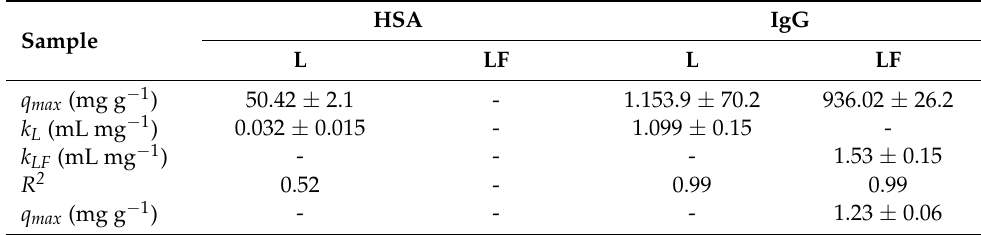
Table 4. Adjusted parameters by Langmuir and Langmuir–Freundlich (LF) for protein adsorption (HSA and IgG diluted in TRIS/HCl 25 mM at pH 9.0) in the Si-adsorbent.